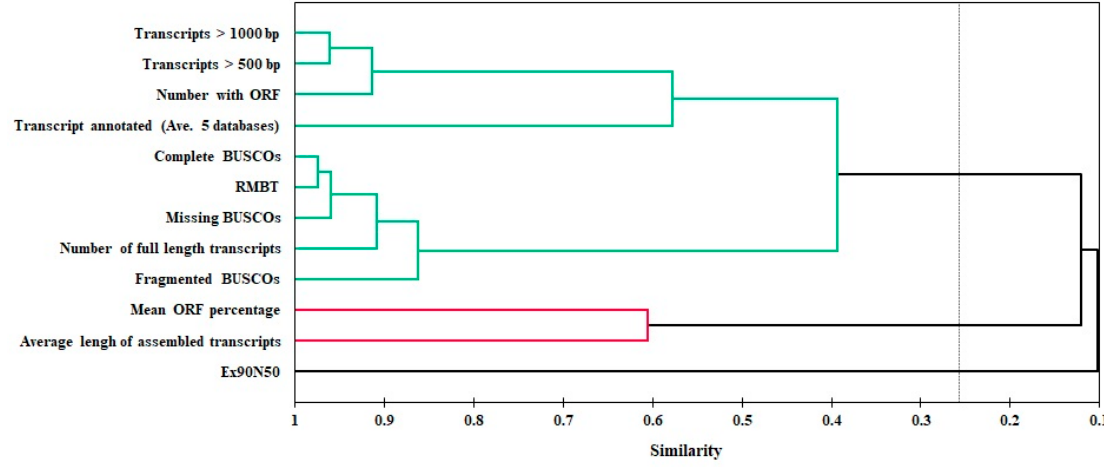
Figure 10. Dendrograms from the agglomerative hierarchical cluster analysis (AHC) performed on evaluation metrics. Three different groups are shown with different